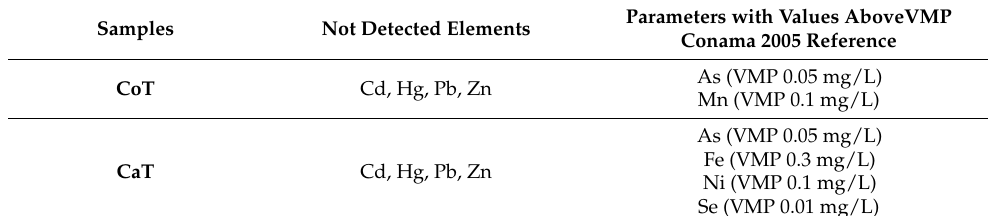
Table 3. VMP—maximum allowed values From Brazilian Law—CONAMA [54].